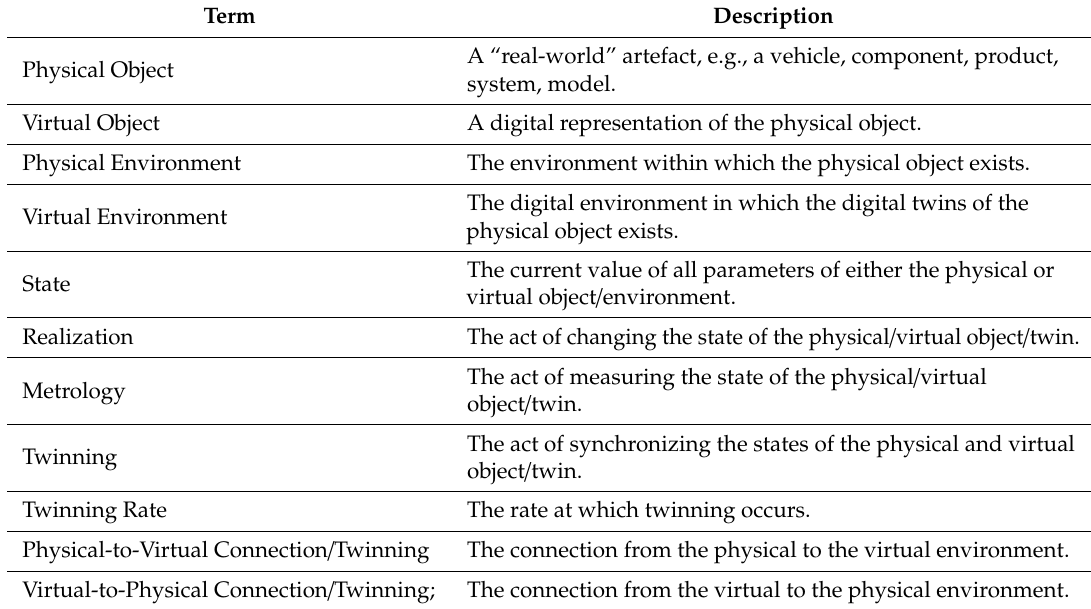
Table 2. Selected and used key concepts related to digital twins (adapted from [22]).